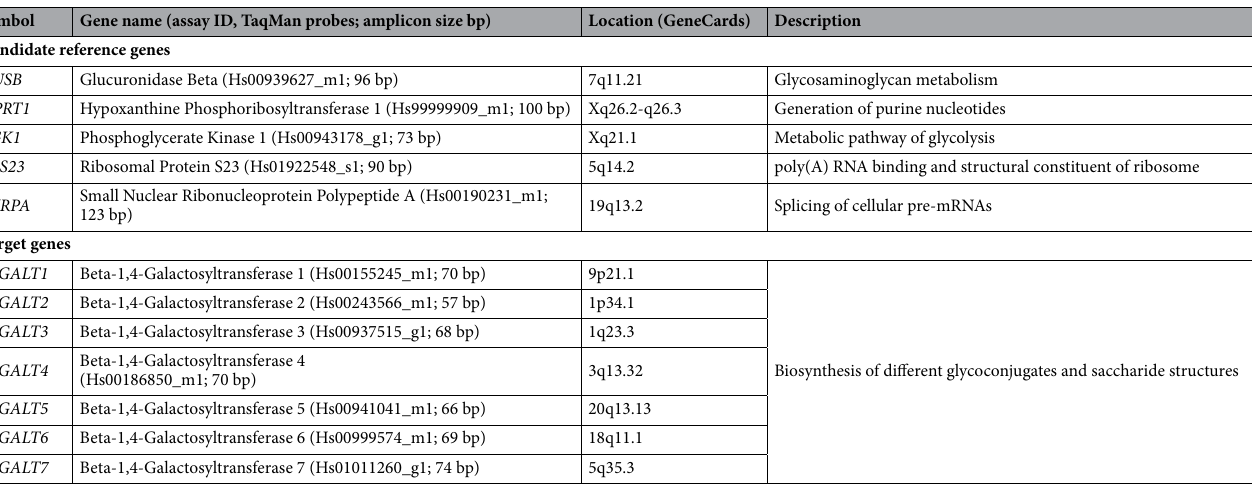
Table 2. Summary of candidate reference and target